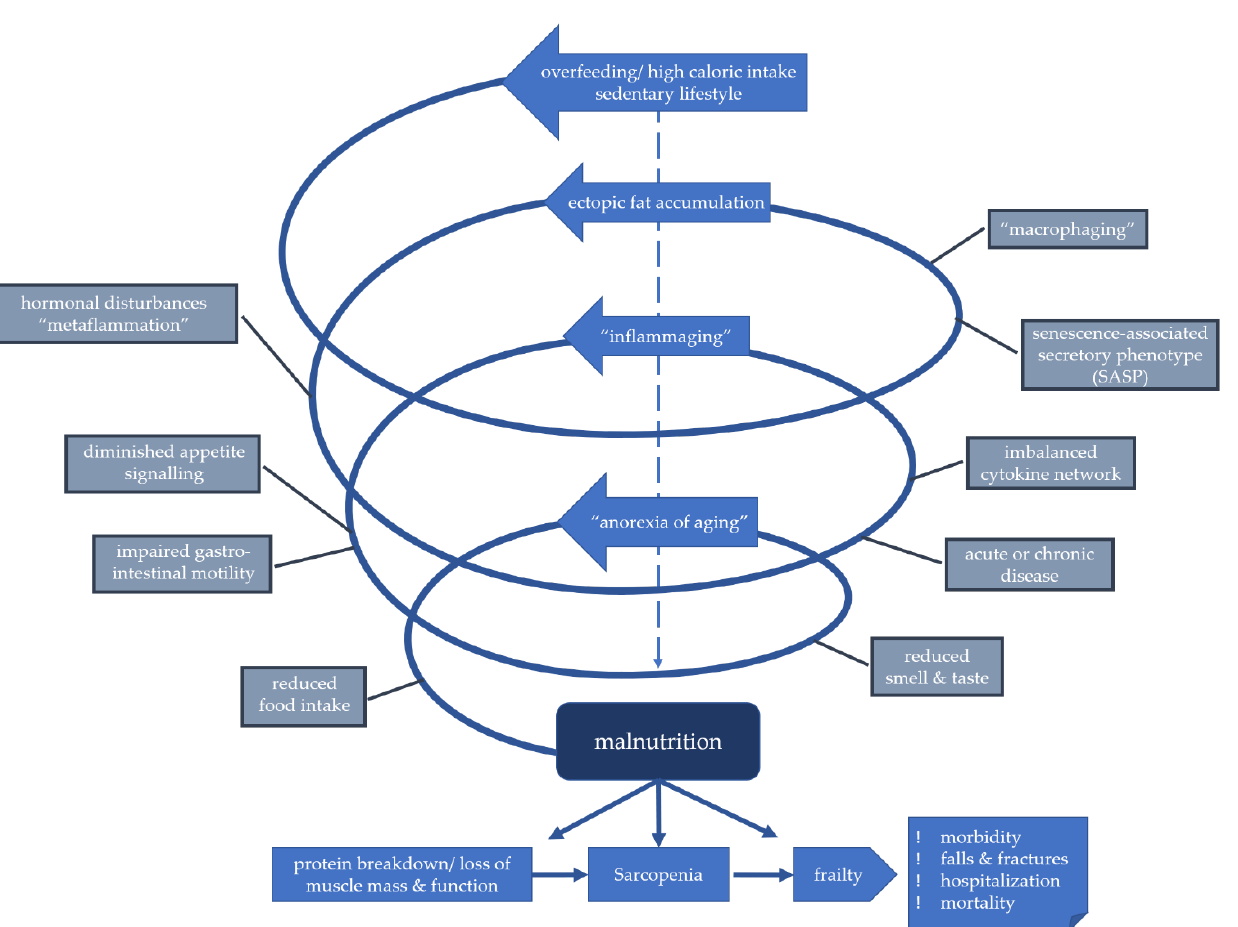
Figure 1. Model of downward spiral in the development of malnutrition in higher age.